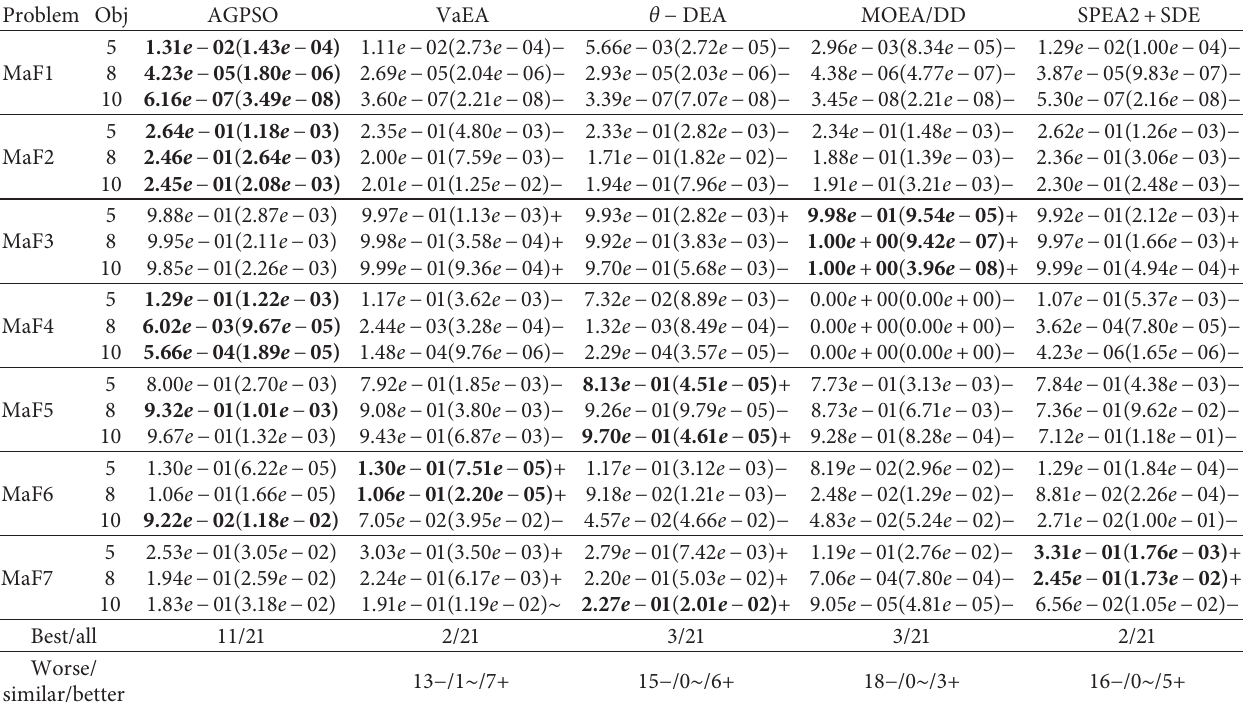
Table 5: Comparison of results of AGPSO and four current MOEAs on Maf1-Maf7 using HV. Problem Obj